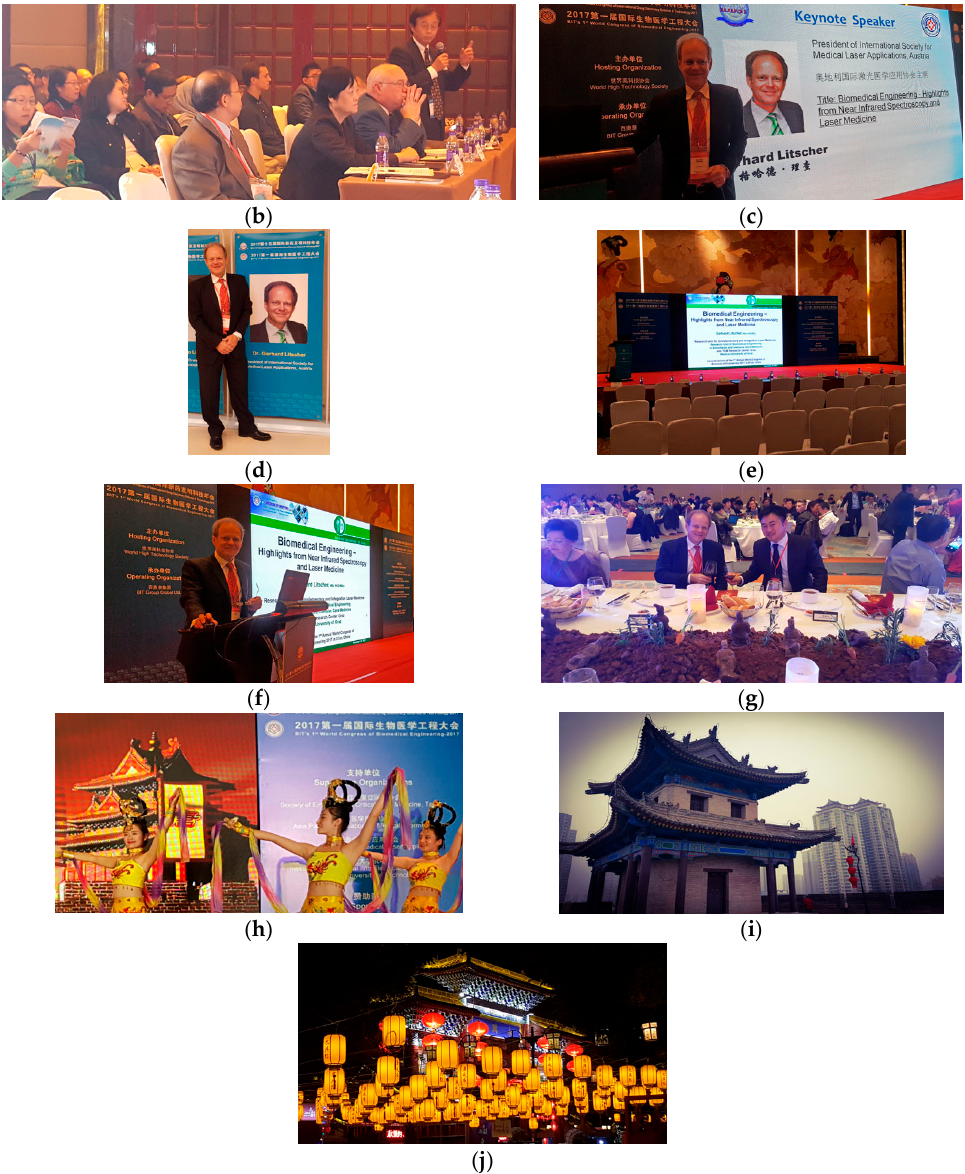
Figure 28. First World Congress (BIT) of Biomedical Engineering ( a – j ) 9–12 November 2017. ( a )